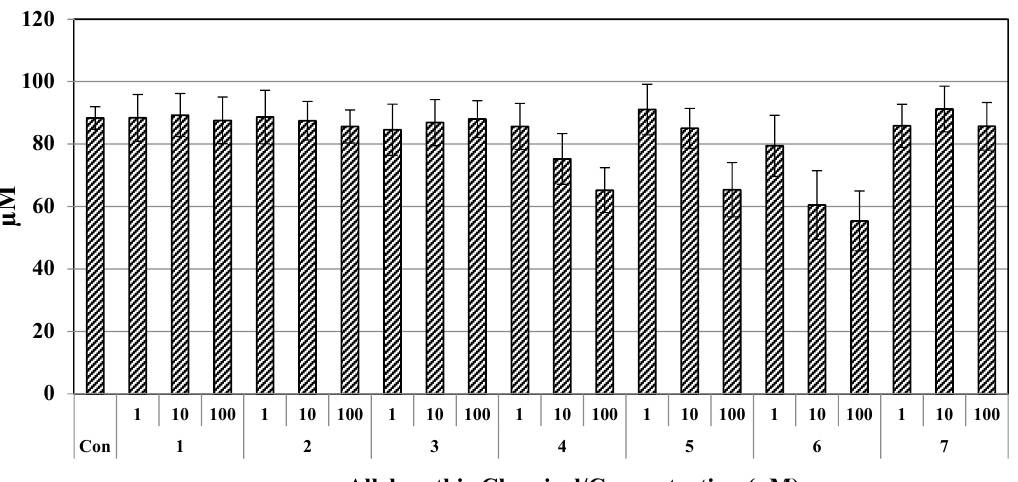
Figure 8. Cell viability of RAW 264.7 cell exposed to isolated chemical constituents of the straw and leaves of O. sativa . Solutions of the seven allelopathic chemical constituents (10% MeOH in distilled water); Data represent the absorbance values obtained from the MMT assay over 24 h. The cell viability percentage was the mean absorbance of seven allelopathic chemical constituents at different concentrations (1, 10, 100 μ M) divided by that of the corresponding control group. The bars represent the mean ± SD obtained in three independent experiments.